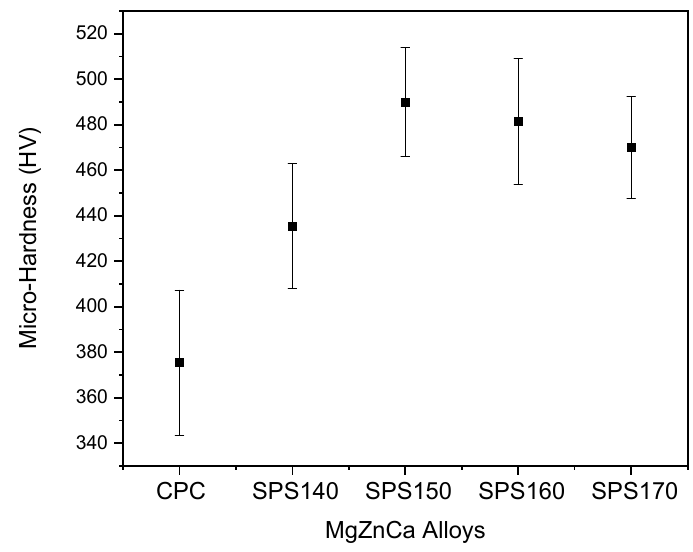
Figure 5. Micro-hardness of Mg-Zn-Ca BMGs.